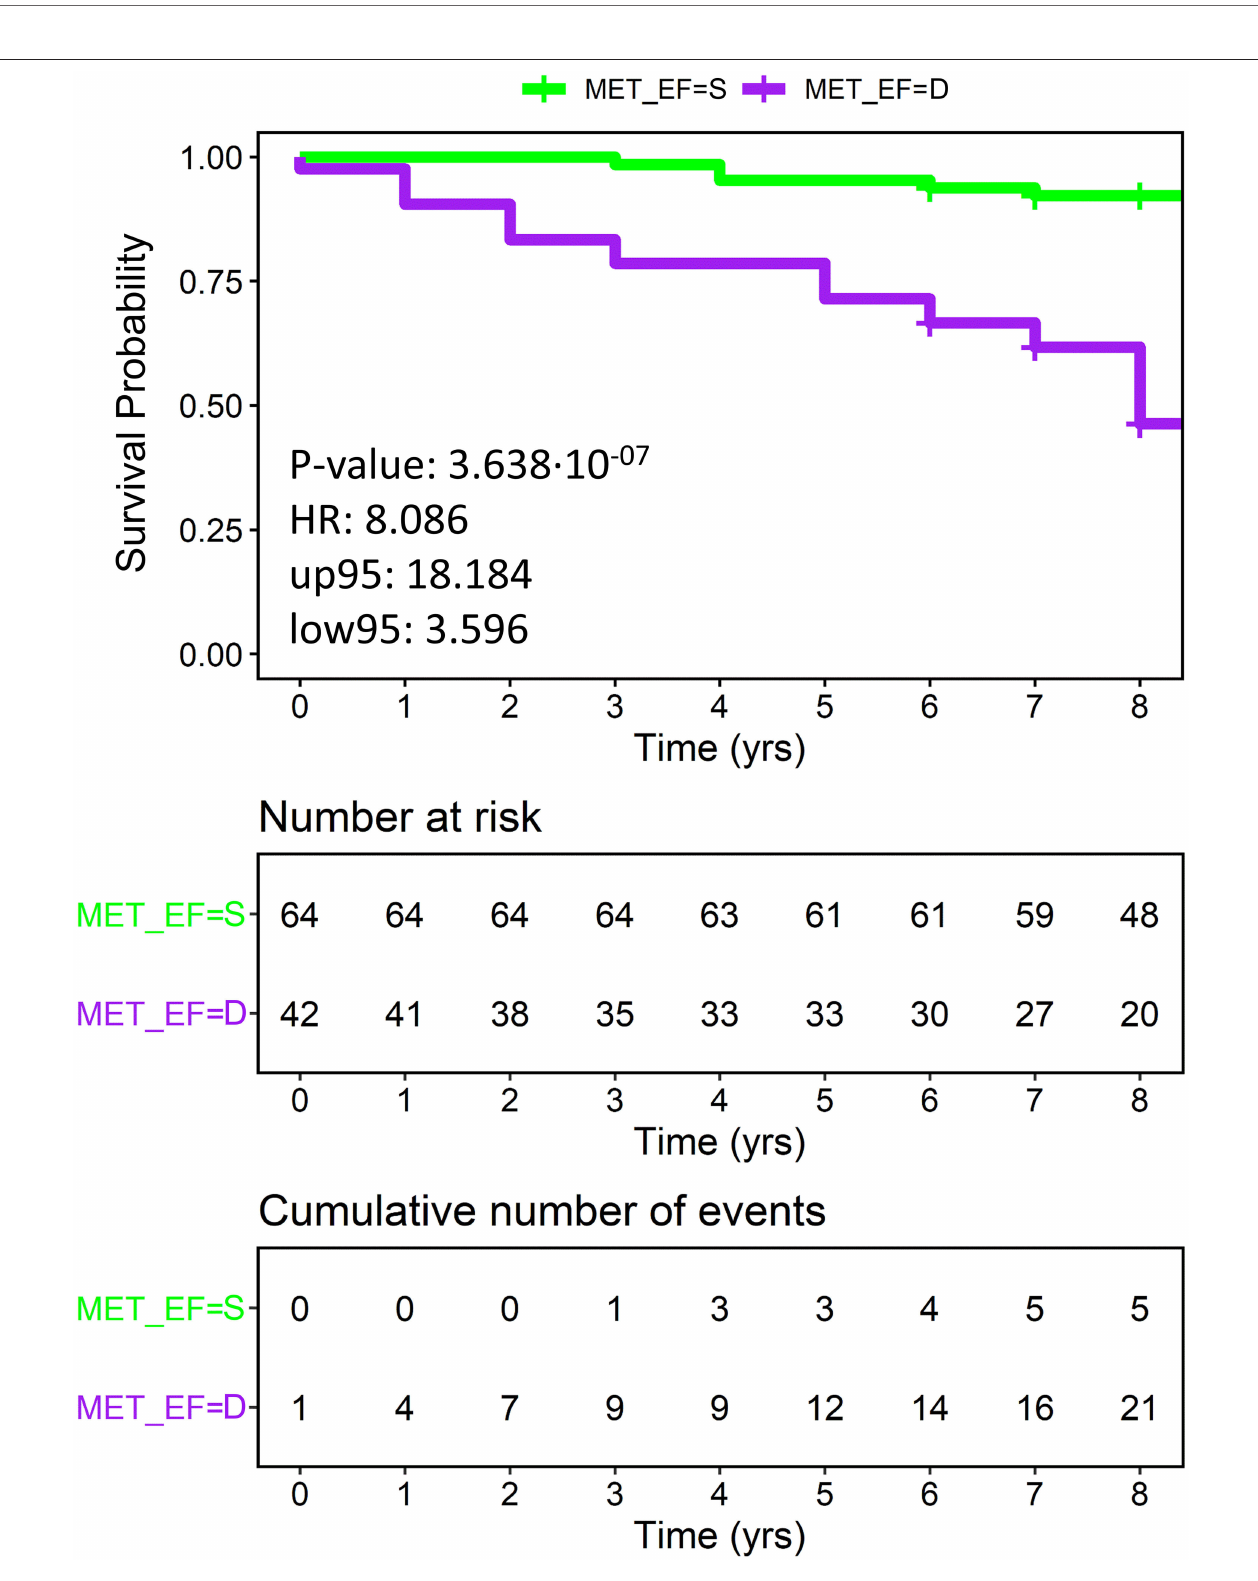
FIGURE 5 | Overall patients with HF, plotting actual survival over time (measured in years) according to risk estimated using a combination of metabolomics and ejection fraction (KM curves). Low metabolomic risk (green) and high metabolomic risk (purple) patients are significantly clustered with a p -value of 3.64 · 10 −